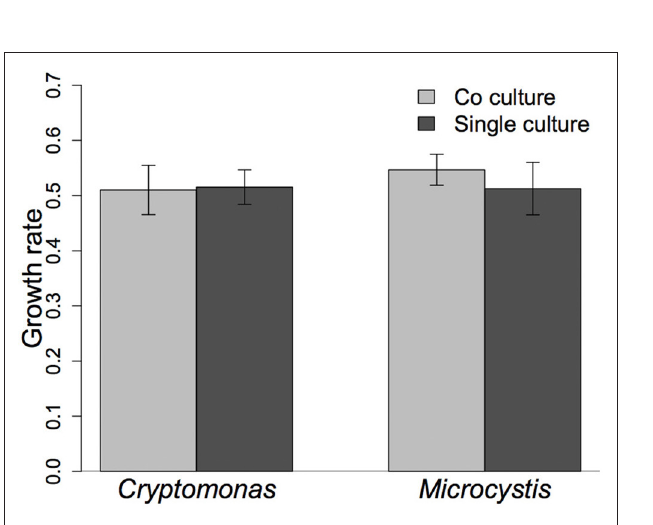
FIGURE 4 | The mean net growth rate (cell.day − 1 ) of each phytoplankton in 6-day facilitation experiment compared between treatments with copepods ( + Z, n = 4) and no-grazer controls (–Z, n = 4). Error bars show confidence interval. *Represents a significant difference (i.e., p < 0.05) between control and